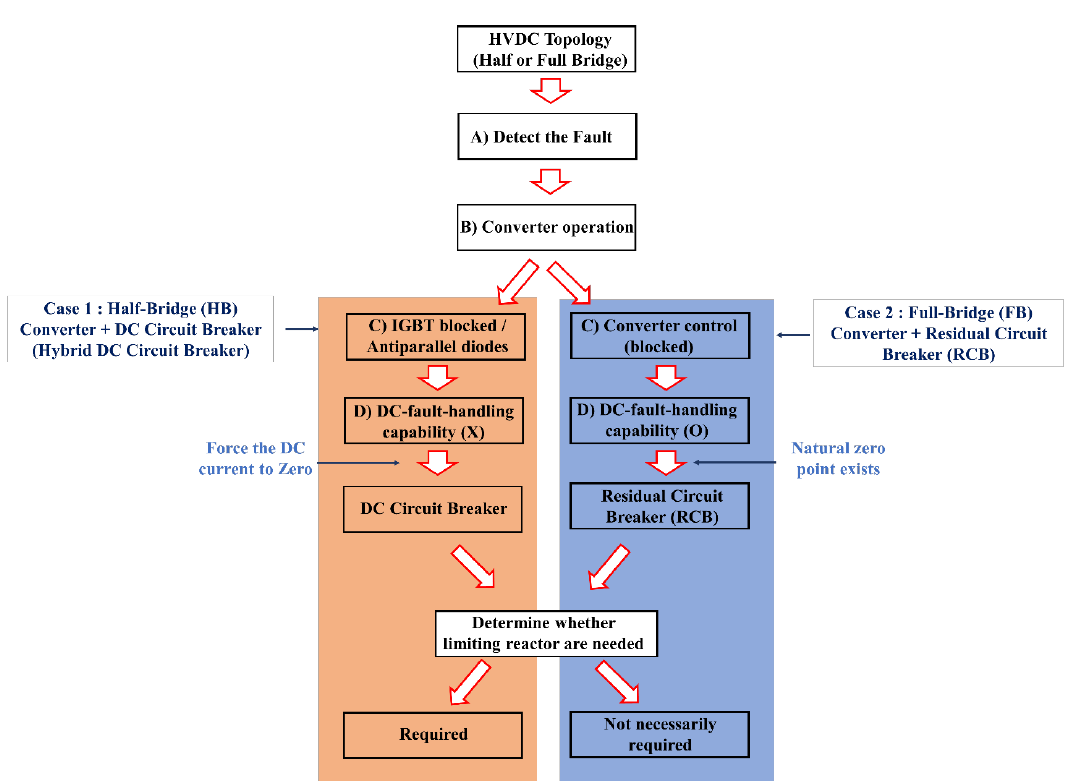
Figure 3. Comparison of overall operating characteristics and the need for a current-limiting reactor .